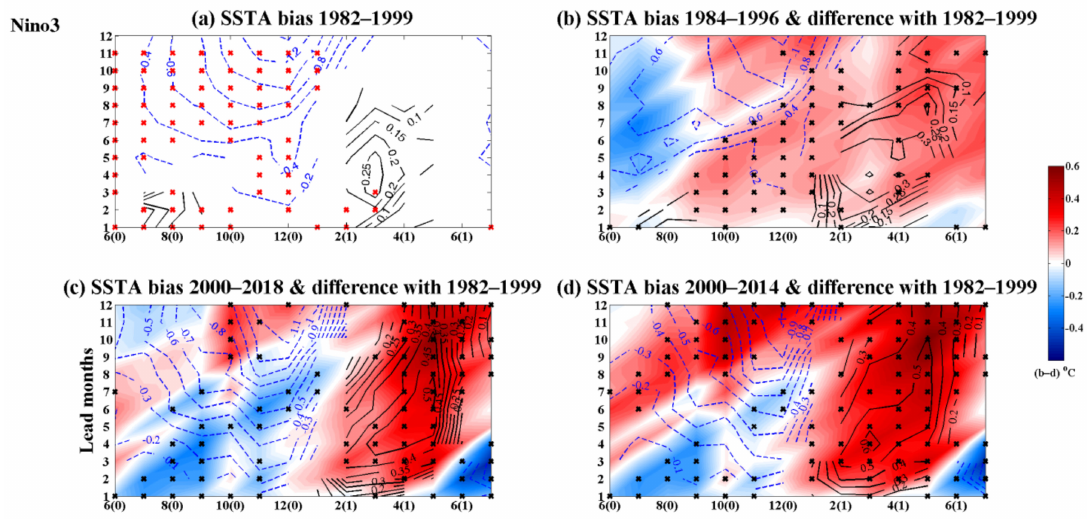
Figure 8. As in Figure 7, but for the Niño3